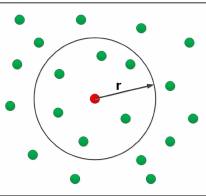
Figure 2. Euclidean model.